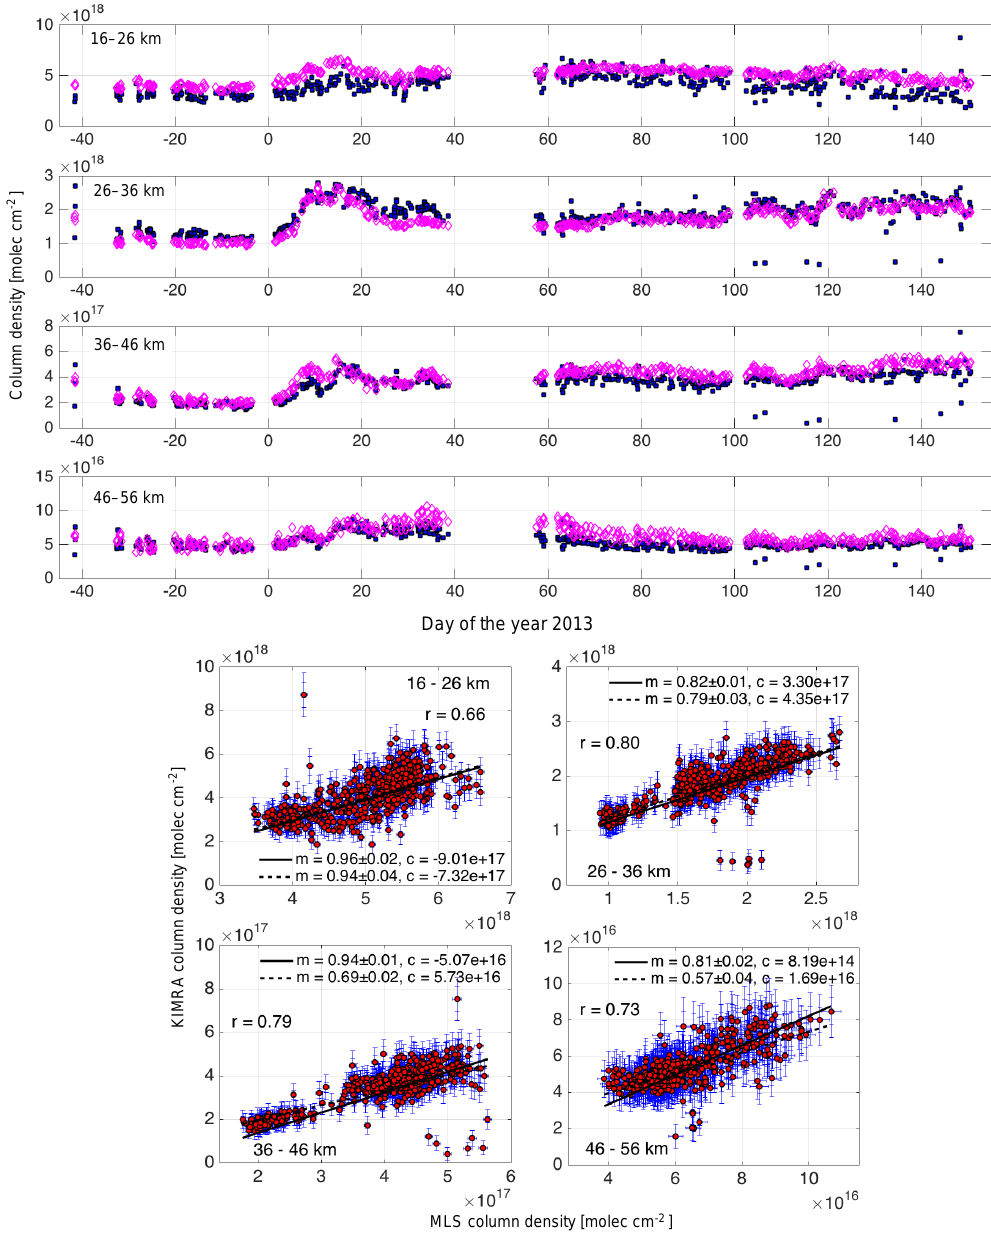
Figure 9. Upper: the O 3 partial column densities from KIMRA (blue filled squares) and coincident MLS (hollow magenta diamonds) measurements plotted against time. Lower: scatter plots of the corresponding coincident data. Error bars and lines of fit are shown for two cases of error estimation for KIMRA, as in Fig. 4. The slope ( m ) and its standard error, and the intercept ( c ) for each line and correlation coefficients are also